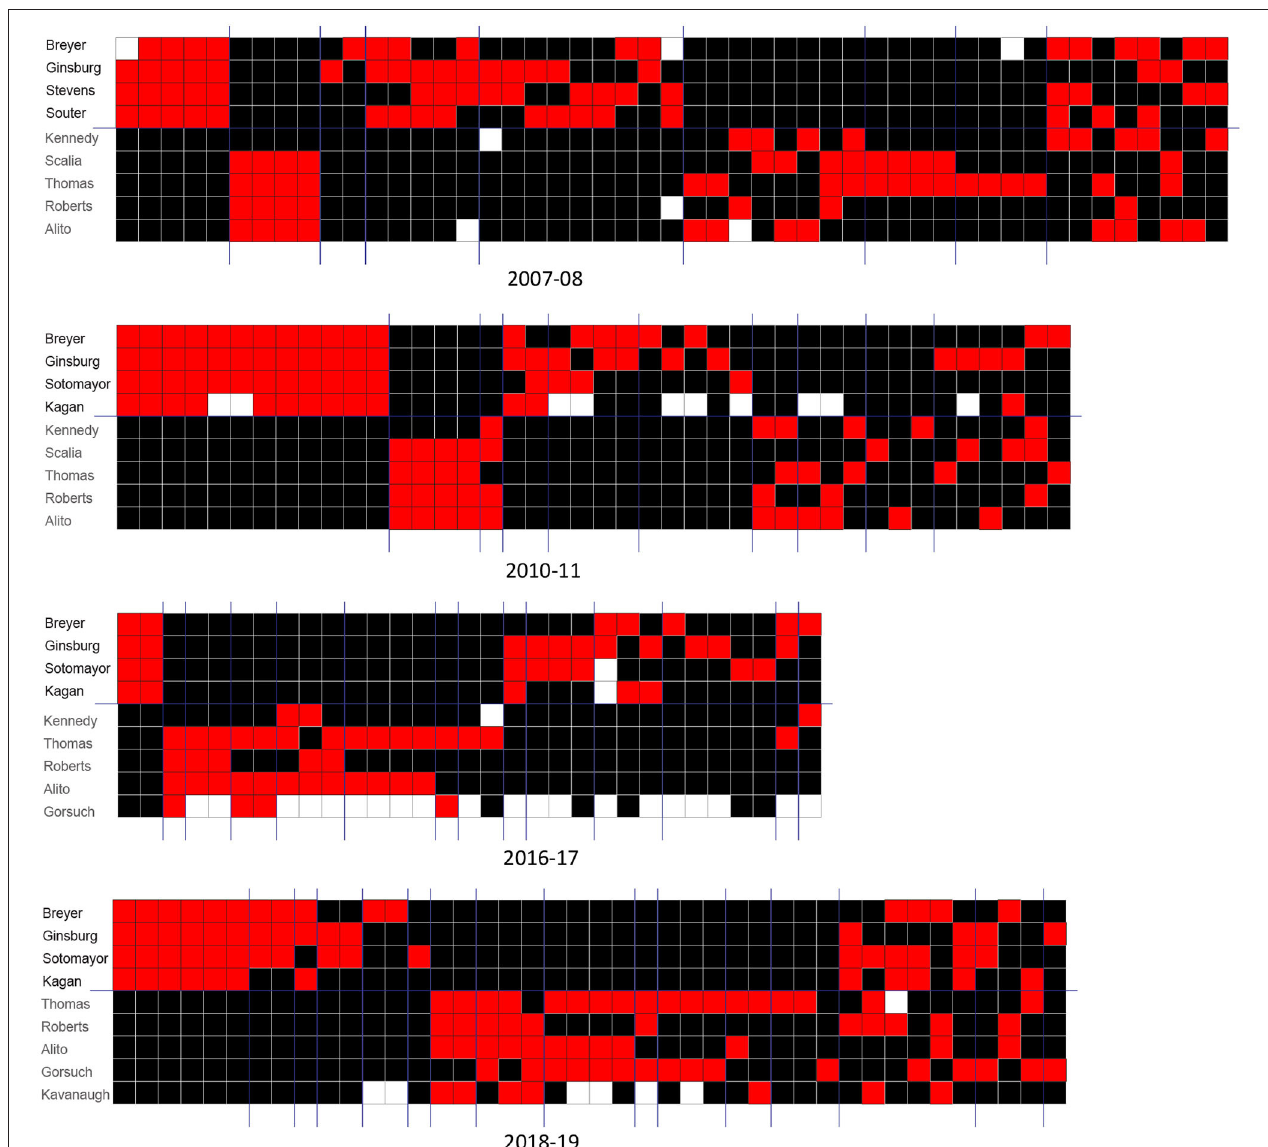
FIGURE 1 | Ordered arrays of decisions for four selected terms of the Roberts Court. Notes: Black squares represent support for a decision, red squares represent dissents and white squares represent non-participation in a